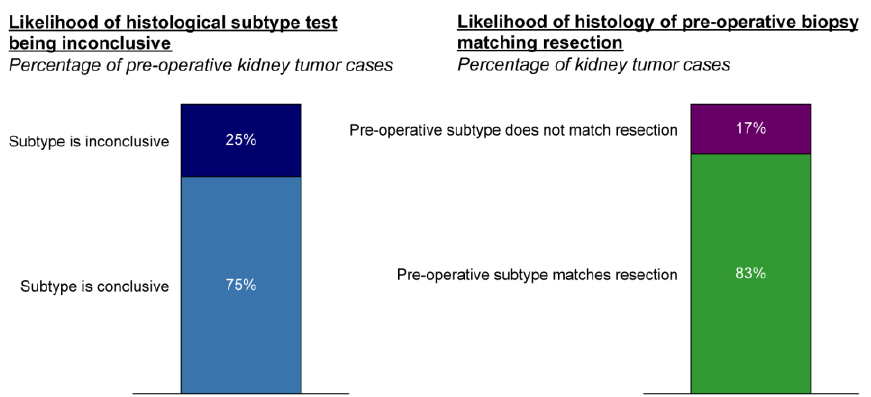
Figure 2. Performance of pre-operative biopsy